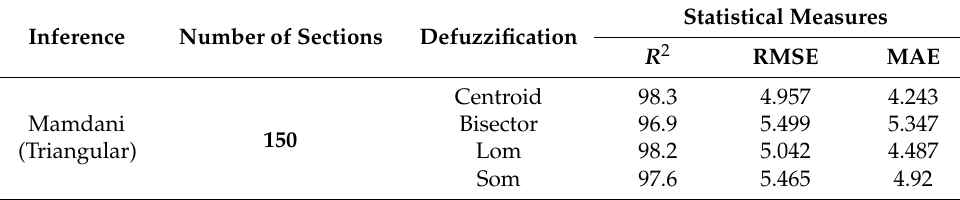
Table 5. Assessment various fuzzy inference systems’ configurations for 150 sections.